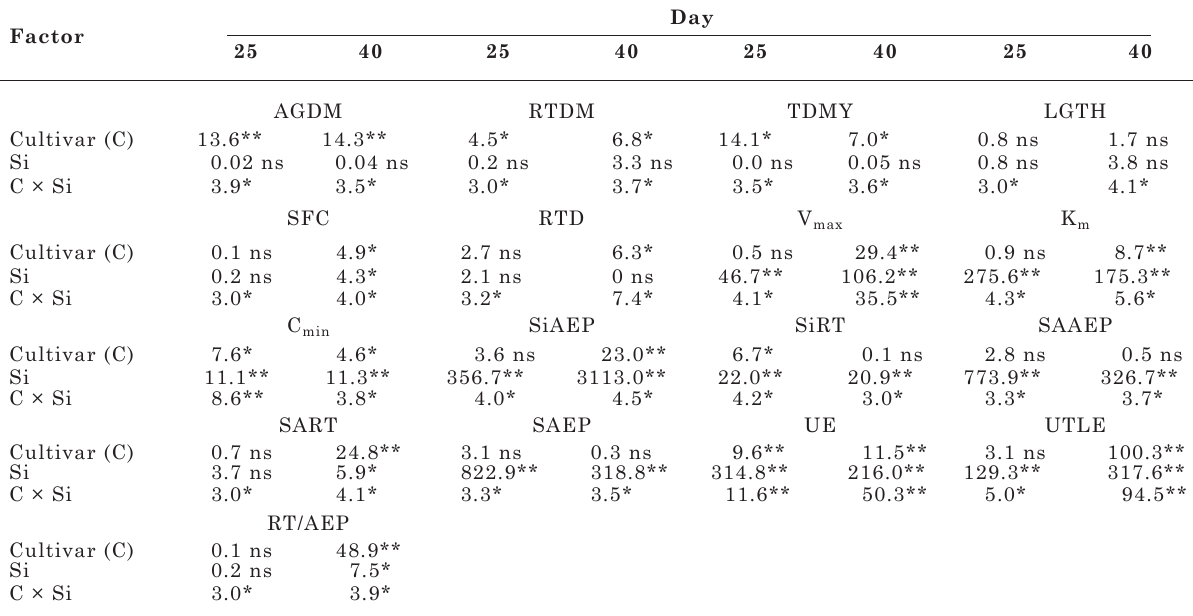
table 1. f values and their respective significance, from the analysis of variance for dry matter yield of the aerial part (DmaeP), root (Dmrt), and total dry matter yield (tDmy), root length (lGtH), sur- face (sfc), and diameter (rtD), si uptake kinetic parameters v max , K m , and c min , si content in the aerial part (siaeP) and root (sirt), si accumulation in the aerial part (saaeP), root (sart), and the entire plant (saeP), si uptake efficiency (Ue), si utilization efficiency (Utle), and root/aerial ratio (rt/aeP) of rice cultivars at different si concentrations in the nutrient solution 25 and 40 days after transfer into growth